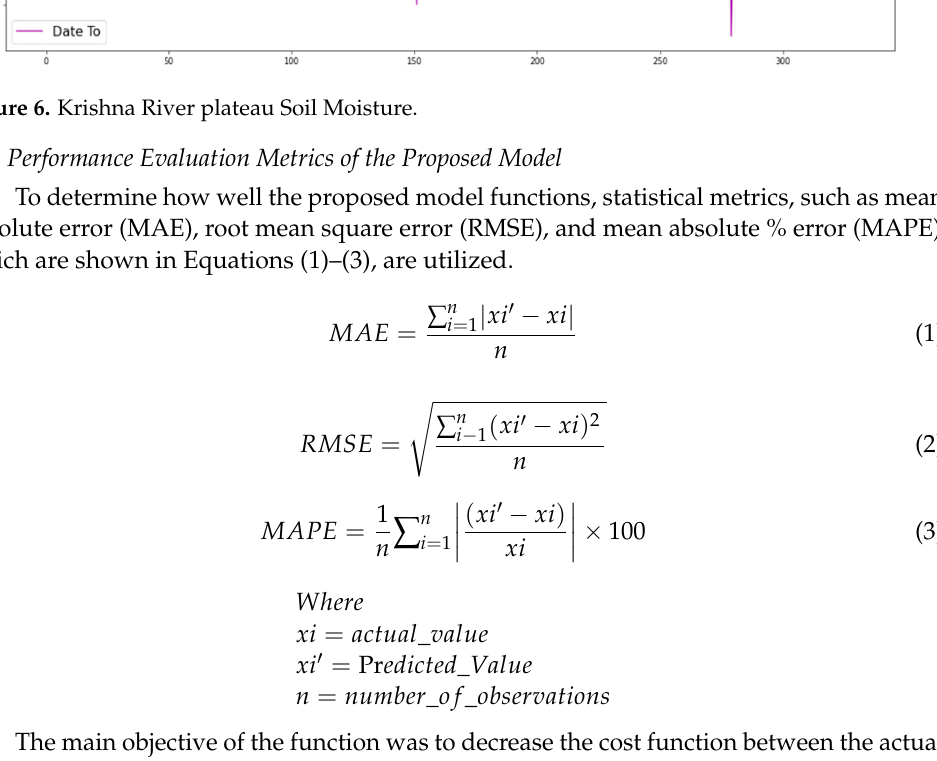
Figure 6. Krishna River plateau Soil Moisture.